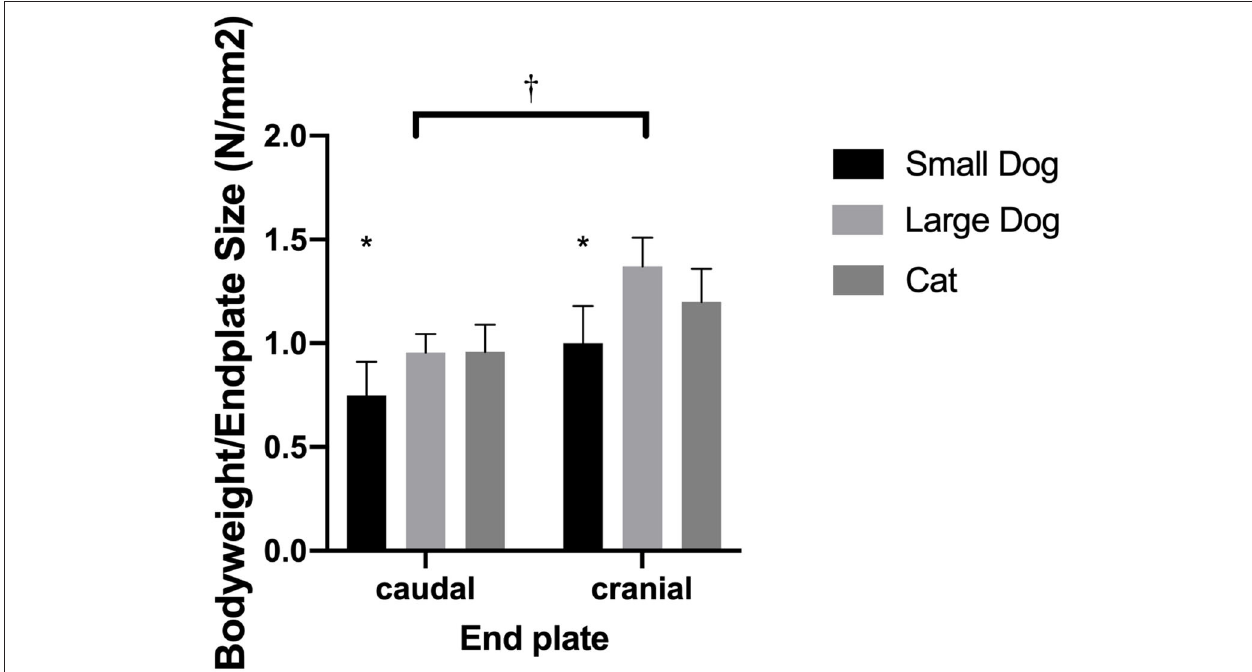
FIGURE 4 | Bar graphs illustrating the different body weight to endplate surface ratio in small- and medium-sized dogs and cats. Results are shown for the caudal and cranial endplate; ratios for the caudal and cranial vertebral endplate were significantly different from each other ( † ). The small dogs showed significantly smaller ratios than cats or medium-sized dogs (*).